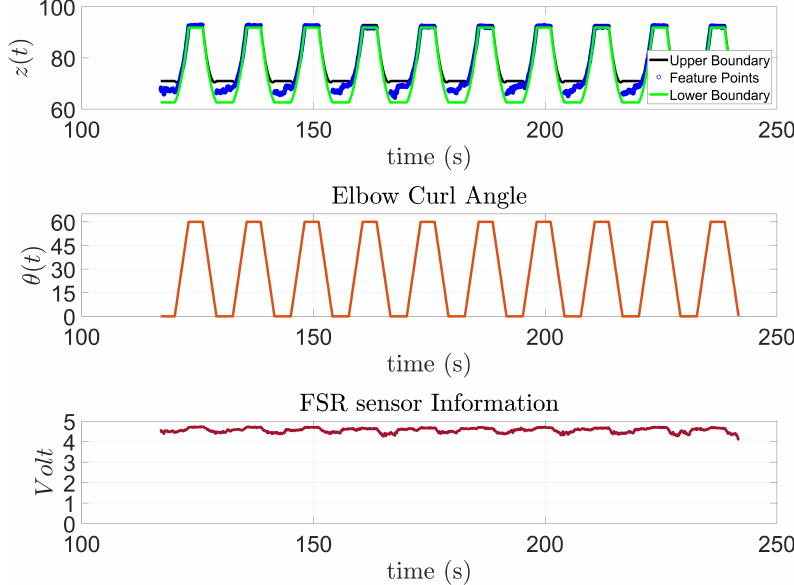
Figure 18. Subject 4: AAN through elbow flexion exercise.